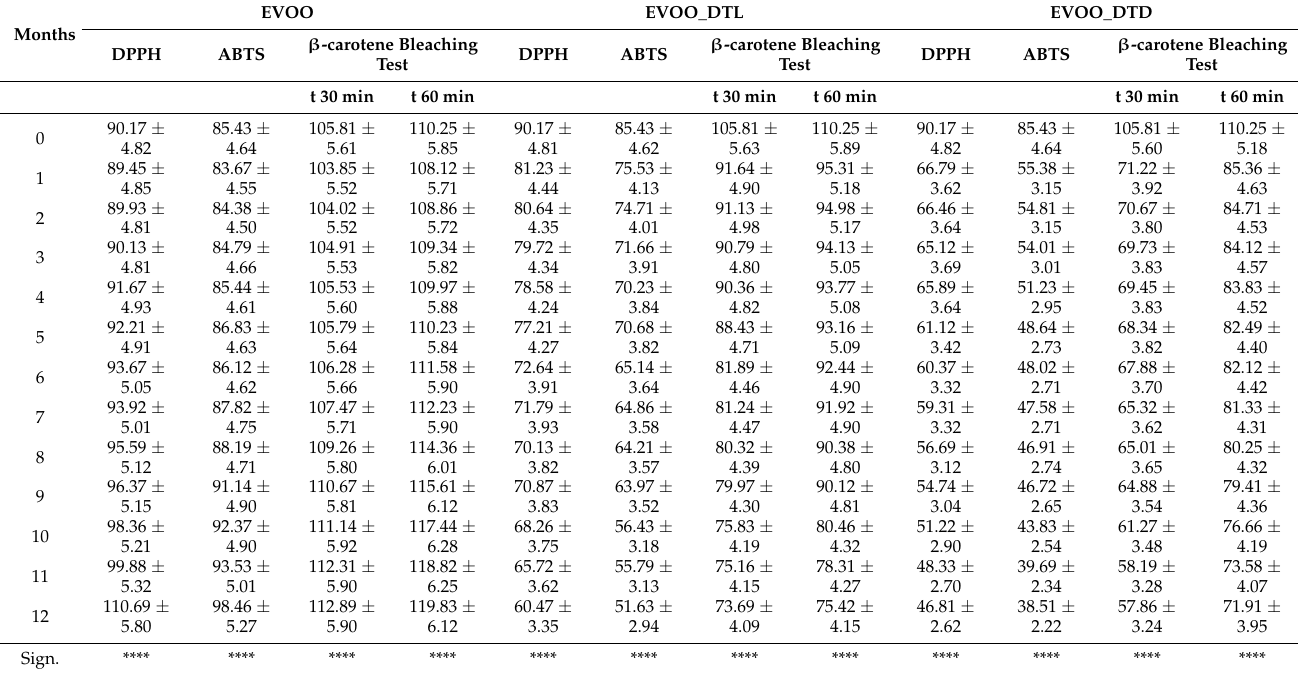
Data are expressed as the mean ± standard deviation (SD) ( n = 3). Differences within and between groups were evaluated by one-way ANOVA followed by a multicomparison Dunnett’s test ( α = 0.05): **** p < 0.0001 compared with the positive controls (Ascorbic acid for DPPH and ABTS test with IC 50 values of 5.0 ± 0.8 and 1.70 ± 0.06, respectively, and propyl gallate for β -carotene bleaching test with IC 50 values of 0.09 ± 0.00 and 0.09 ± 0.01 at 30 min and 60 min incubation,